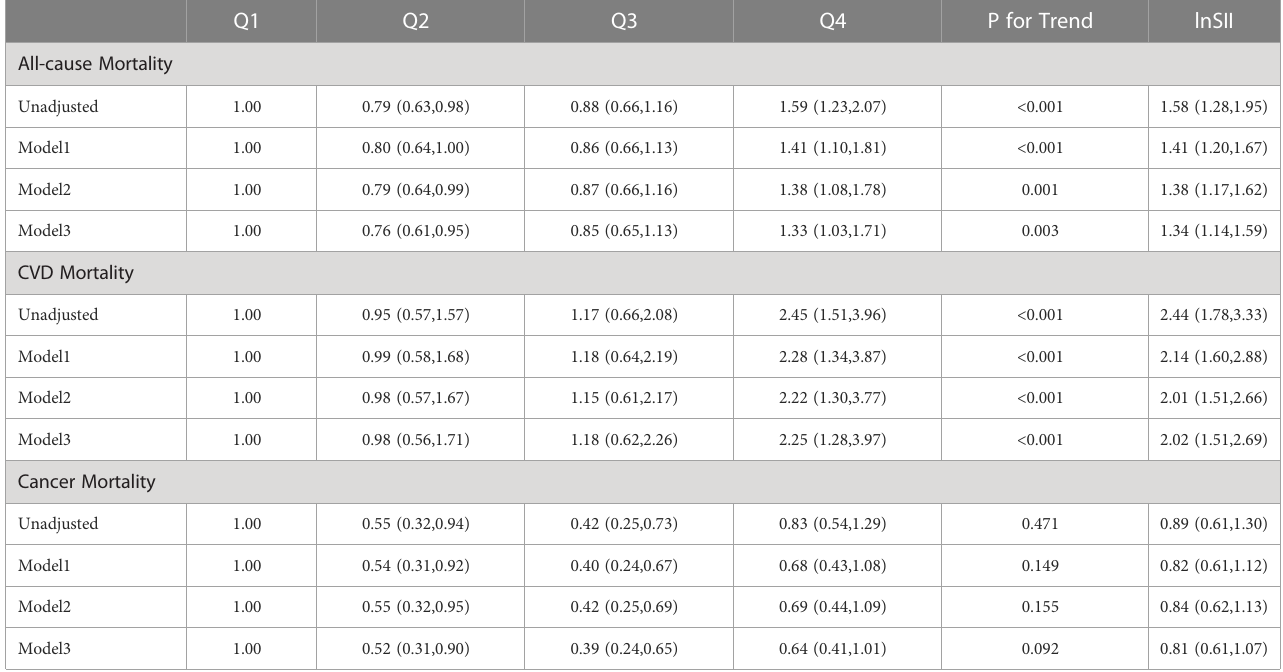
TABLE 2 Weighted association between SII and